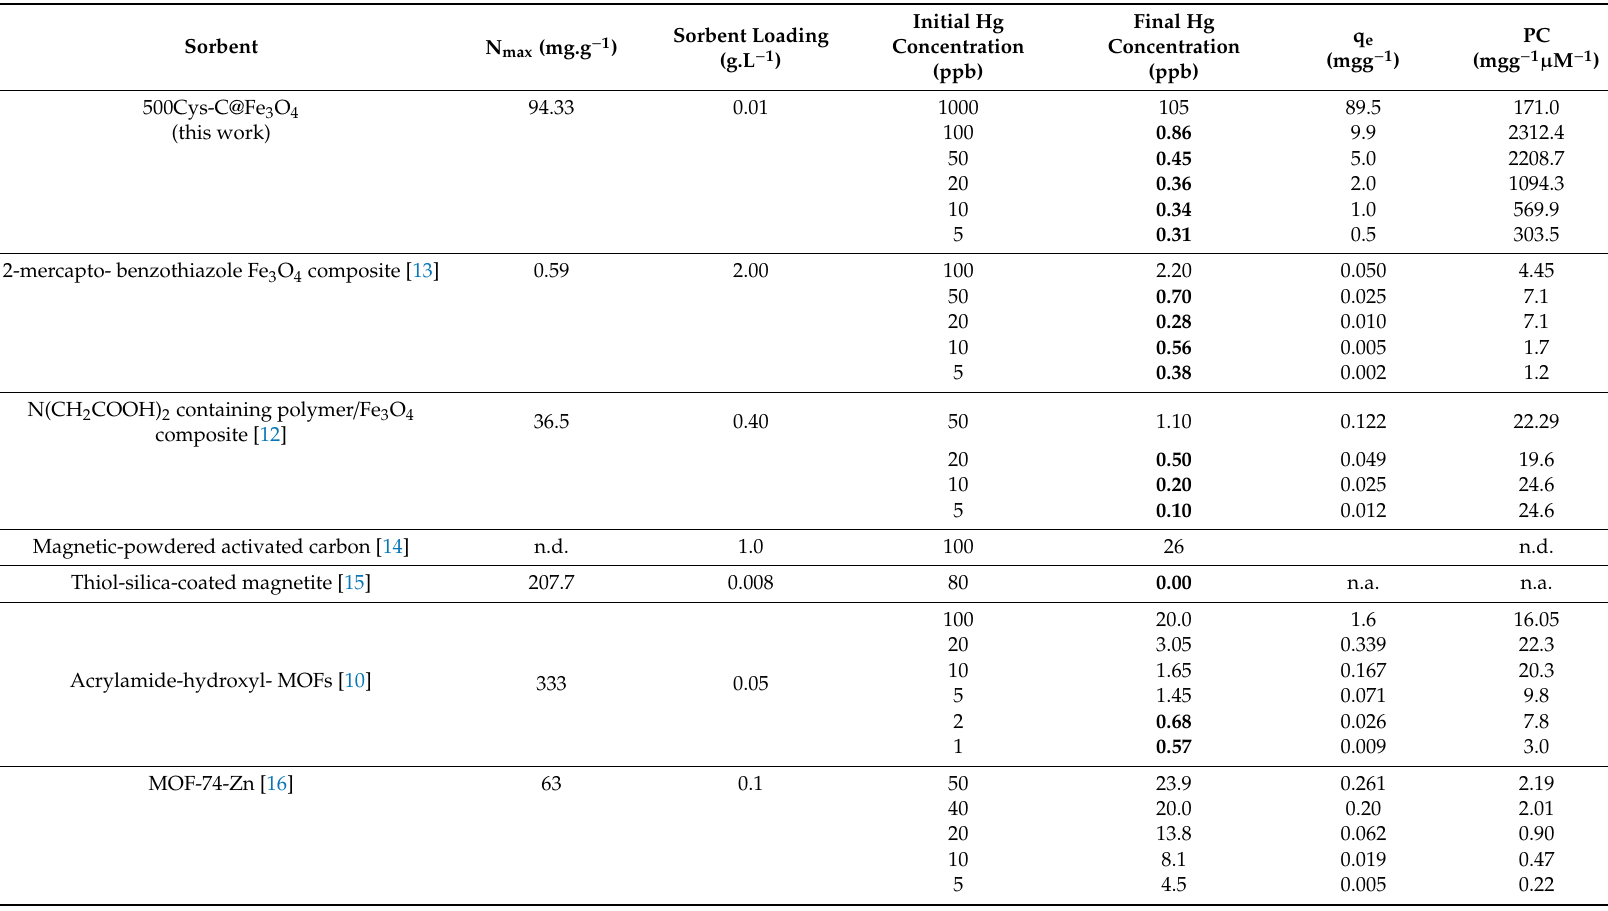
Table 5. Comparative sorption capacities, Hg concentrations before and after treatment, Hg uptake, and partition coe ffi cient values for various sorbents for Hg(II) removal at ultralow metal concentrations. The numbers in bold indicate the Hg(II) concentration lower than the World Health Organization (WHO) and European Union (EU) permissible limits of total mercury in drinking water. Note that n.d. is denoted as not determined as the volume of treated Hg(II) solution is unknown, while n.a is denoted as not applied due to the partition coe ffi cient (PC) value is infinity using Equation